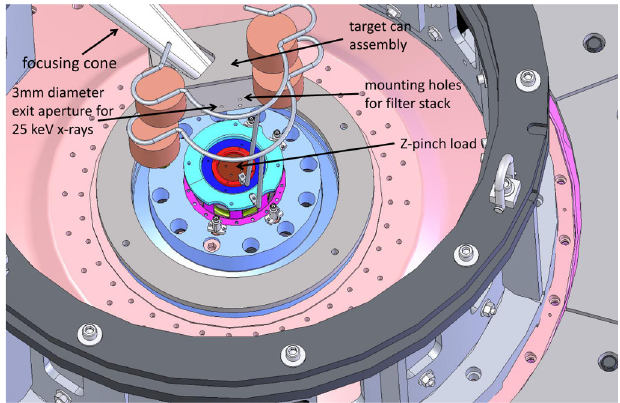
FIG. 8. (Color) Computer-aided design model of the Z -center section. One can see the final focusing cone as it enters the target